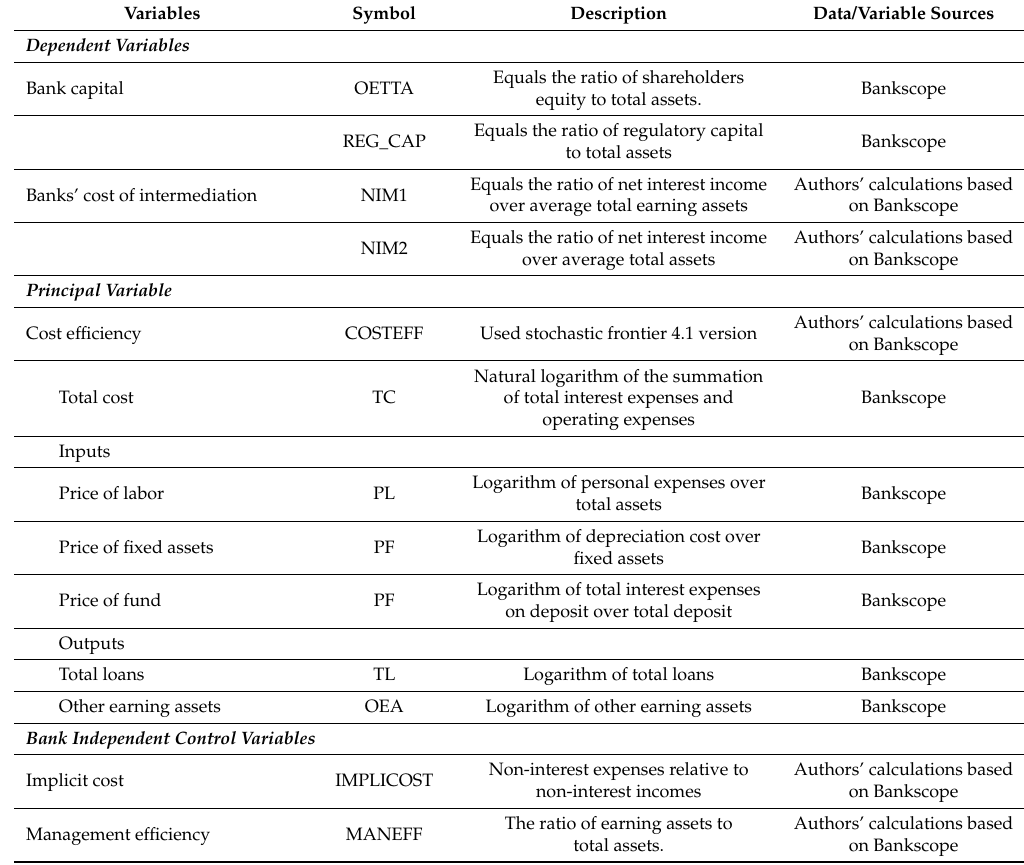
Table 1. Description of the